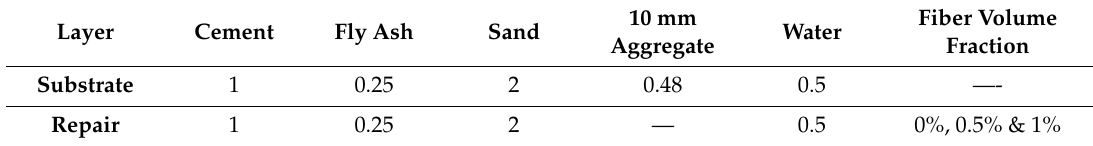
Table 1. Mix proportions of substrate and repair layers.